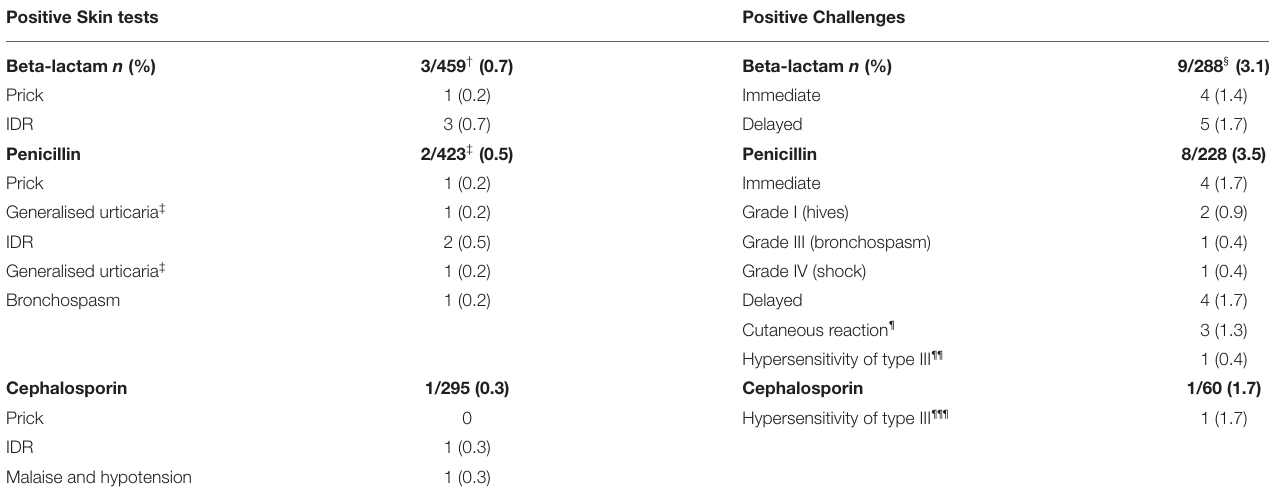
TABLE 3 | Safety of skin tests in 459 patients and in 288 drug